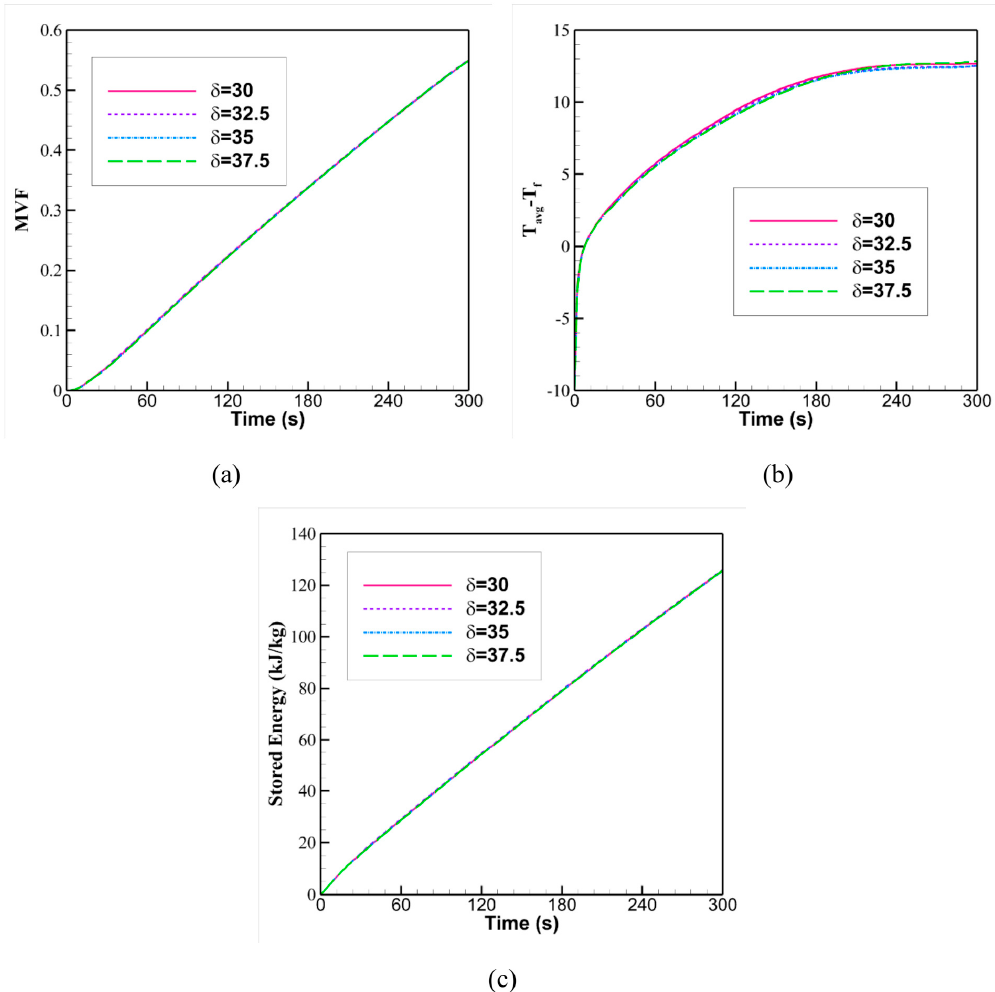
Figure 6. The ( a ) melting volume fraction, ( b ) surface heat transfer rate, and ( c ) stored energy as a function of time when ε = 0.95 and ω = 1%.